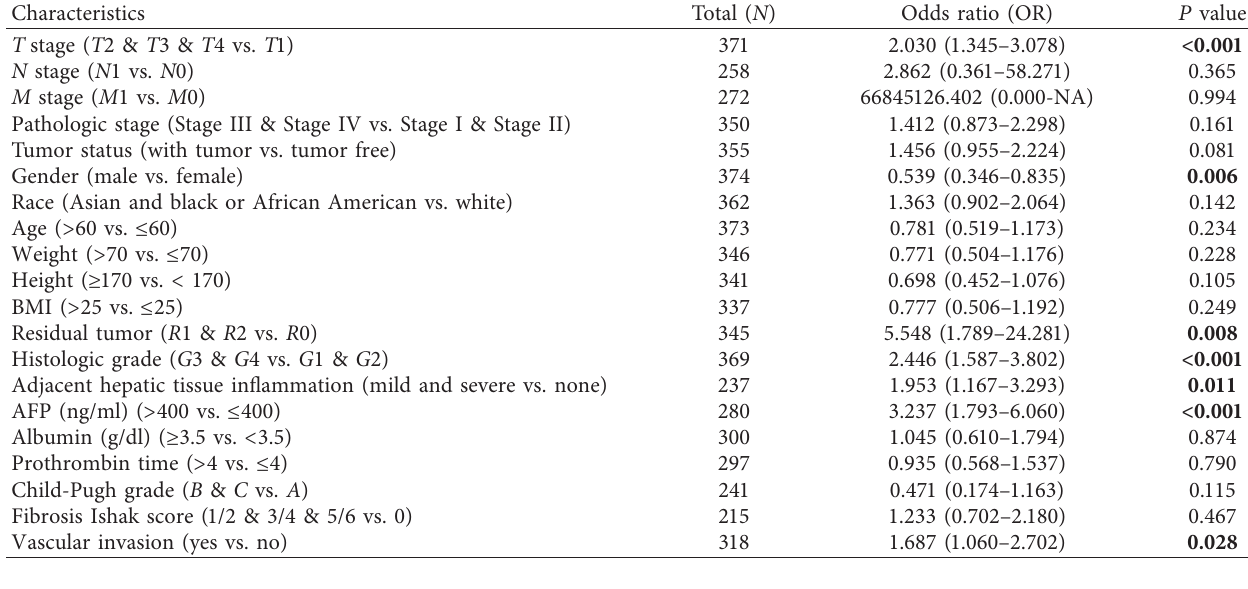
Table 3: ELF3-AS1 expression was associated with clinical characteristics of HCC (logistic regression).